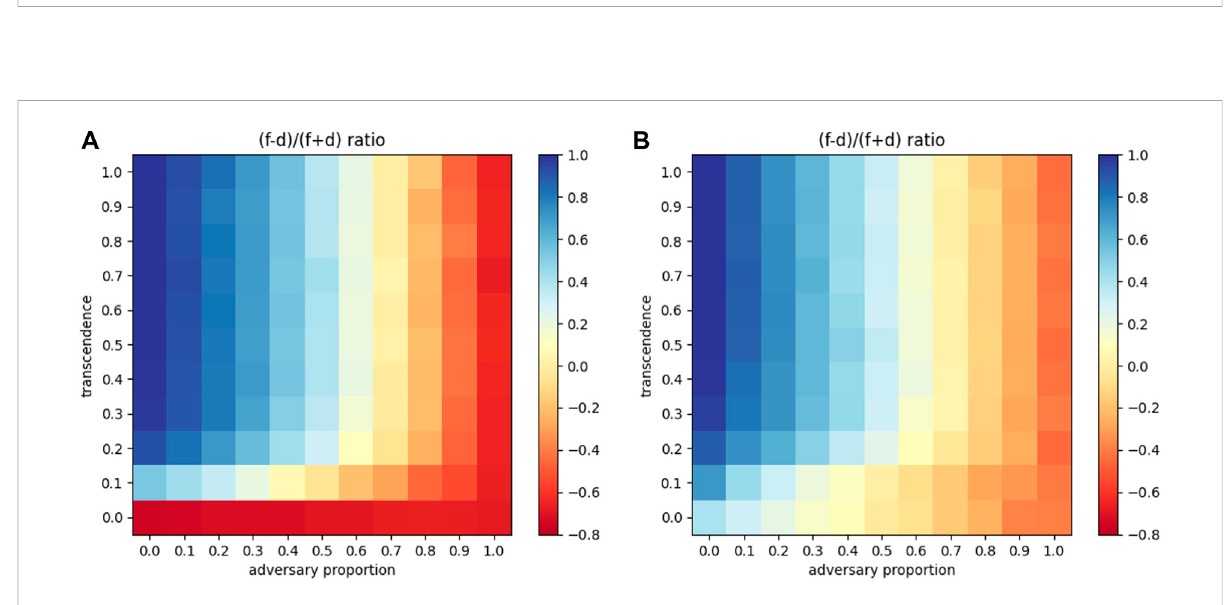
FIGURE 10 2D heatmap of adversarial proportion vs. transcendence for the ratio ( f – d )/( f + d ) (A) With attenuation (B) With attenuation and network elasticity.